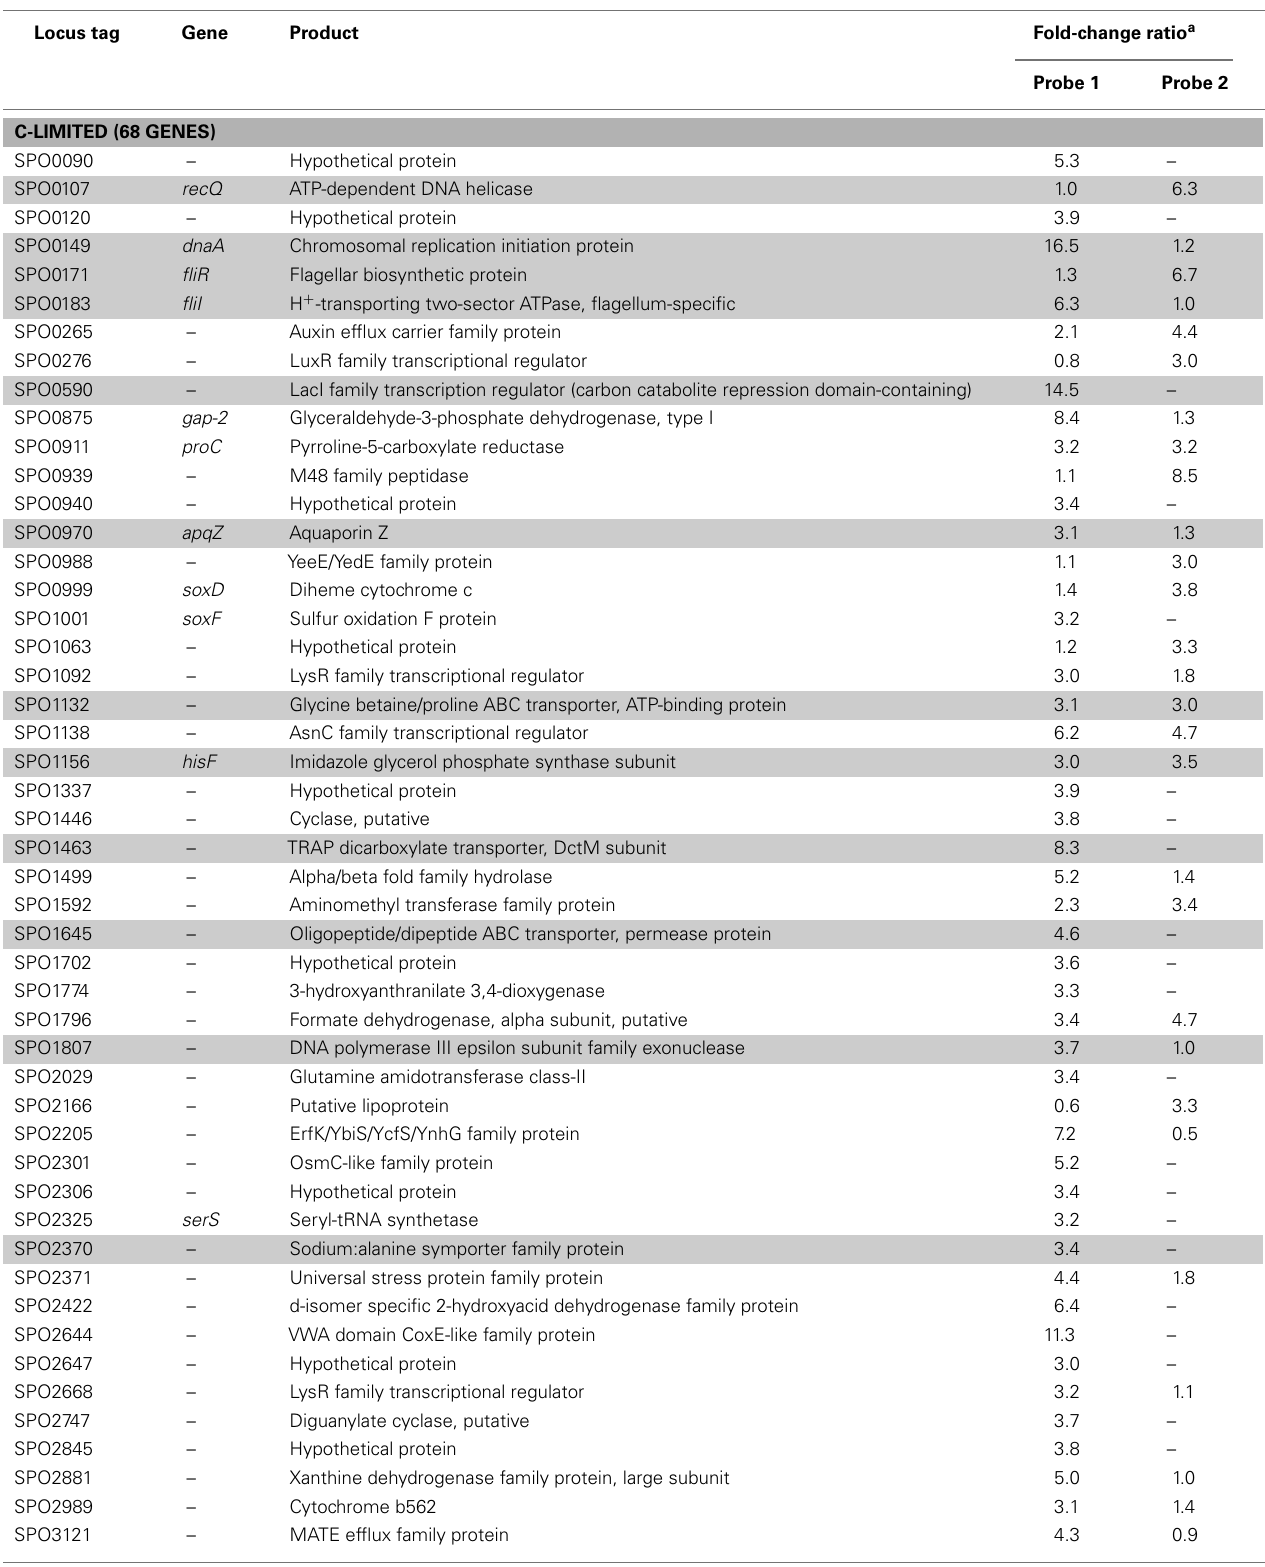
TableA4 |Transcriptionally enriched R. pomeroyi DSS-3 genes. Locus tag